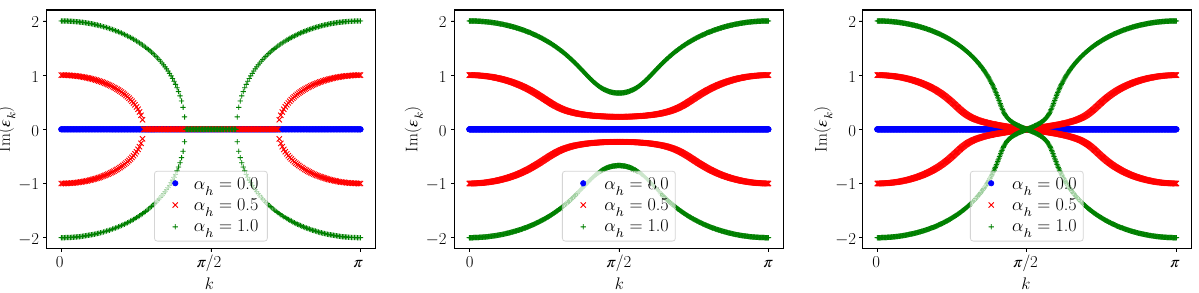
FIG. 11. Imaginary part of the single-particle energy spectrum { ε k } . Left: J = π/ 4, h = π/ 4 + i α h . There exists a finite interval of k modes with real energy [Eq. (B10)] for any noninfinite α h . Middle: J = π/ 4 − 0.1, h = π/ 4 + i α h . Any nonzero α h results in the absence of k modes with purely real energy. Right: J = π/ 4, h = π/ 4 − 0.1 + i α h . Only the k mode with k = π/ 2 supports purely real energy at any nonzero α h .